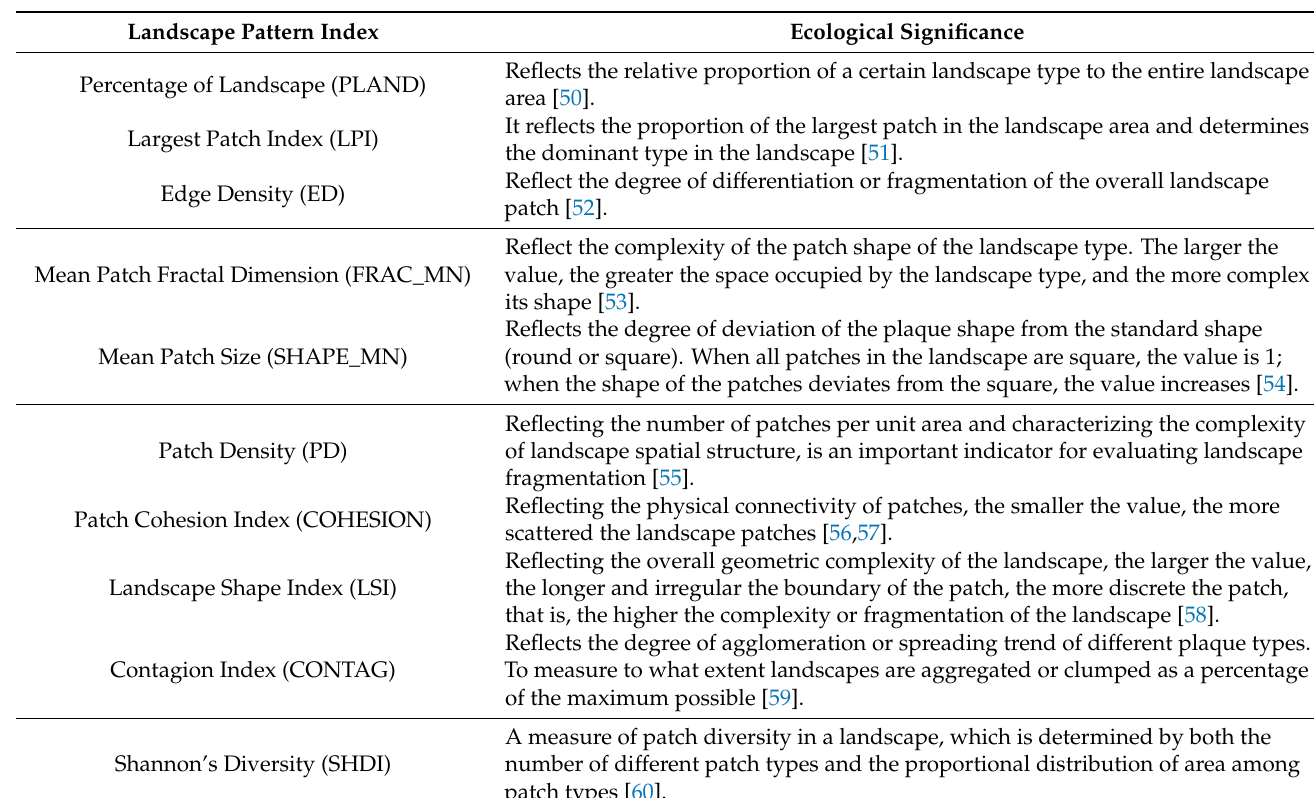
Table A2. Landscape pattern index and its ecological